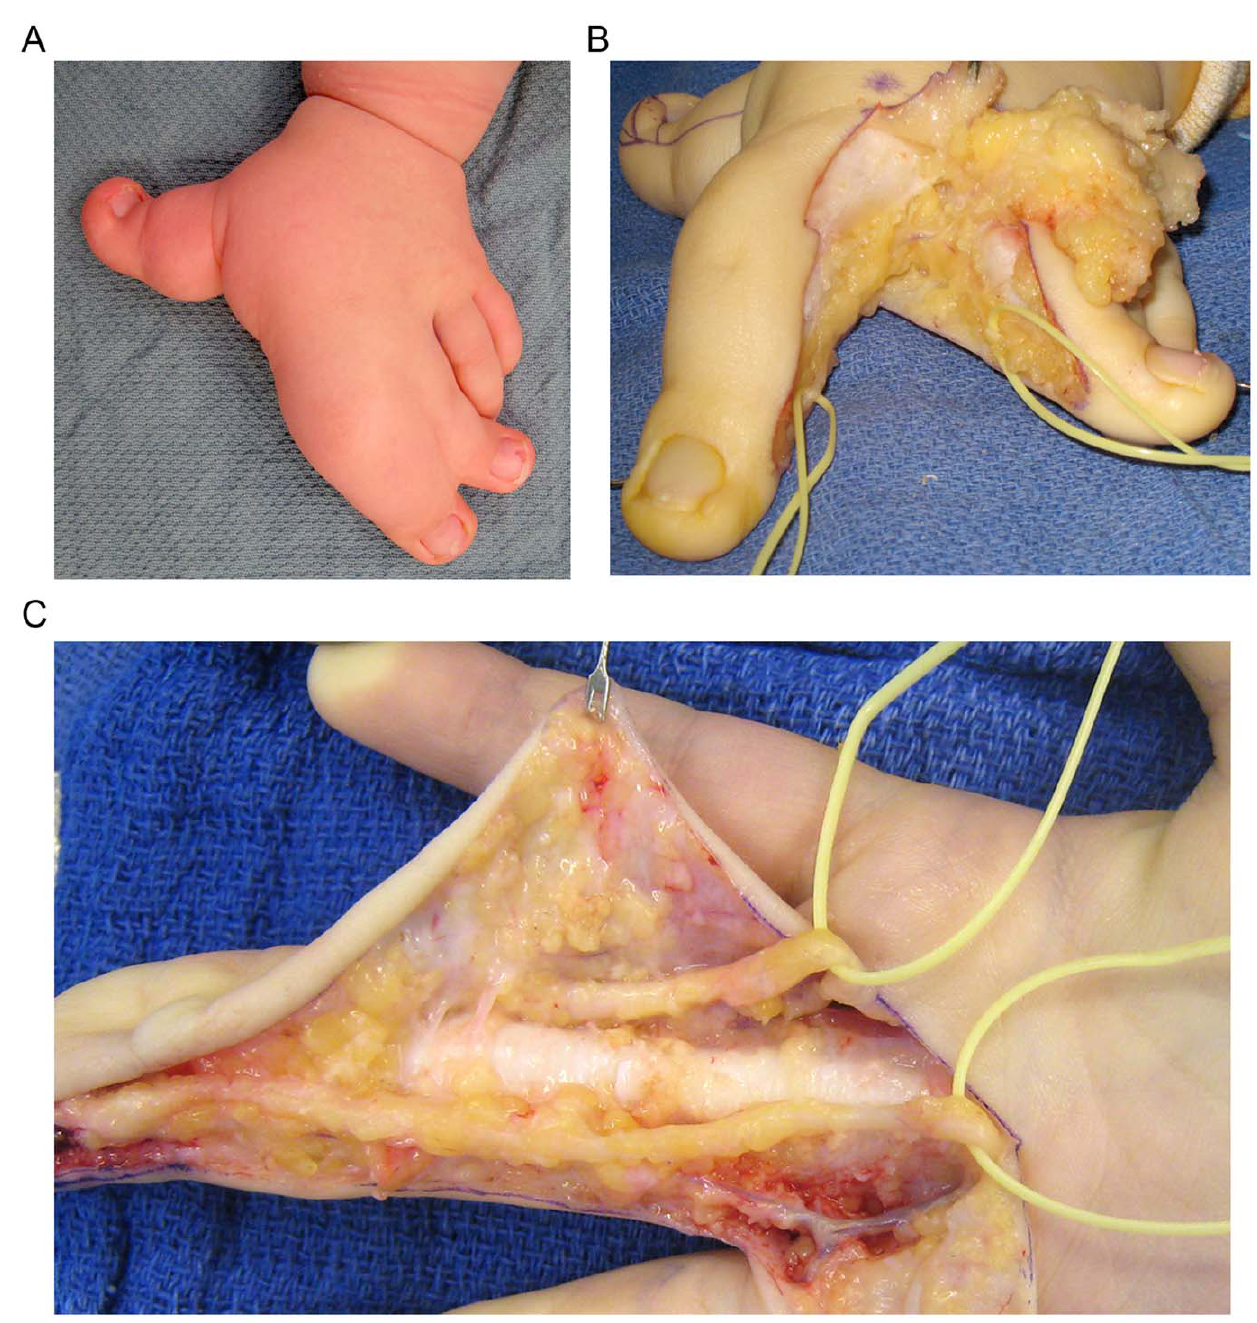
Figure 1. Clinical photos from patients undergoing surgical treatment of macrodactyly. (A) 15 month-old boy with macrodactyly involving the thumb, index and middle fingers. As is often seen, there is associated syndactyly between the index and middle fingers and deviation of all affected digits. (B) The same patient during separation and first stage debulking of the digits. The yellow loops are around the digital nerves, which are enlarged. A large volume of overgrown fat and soft-tissue is being removed. (C) 8 year-old girl with macrodactyly isolated to the middle finger. The excess fat and soft-tissue has been removed revealing enlarged digital nerves tagged with yellow loops.